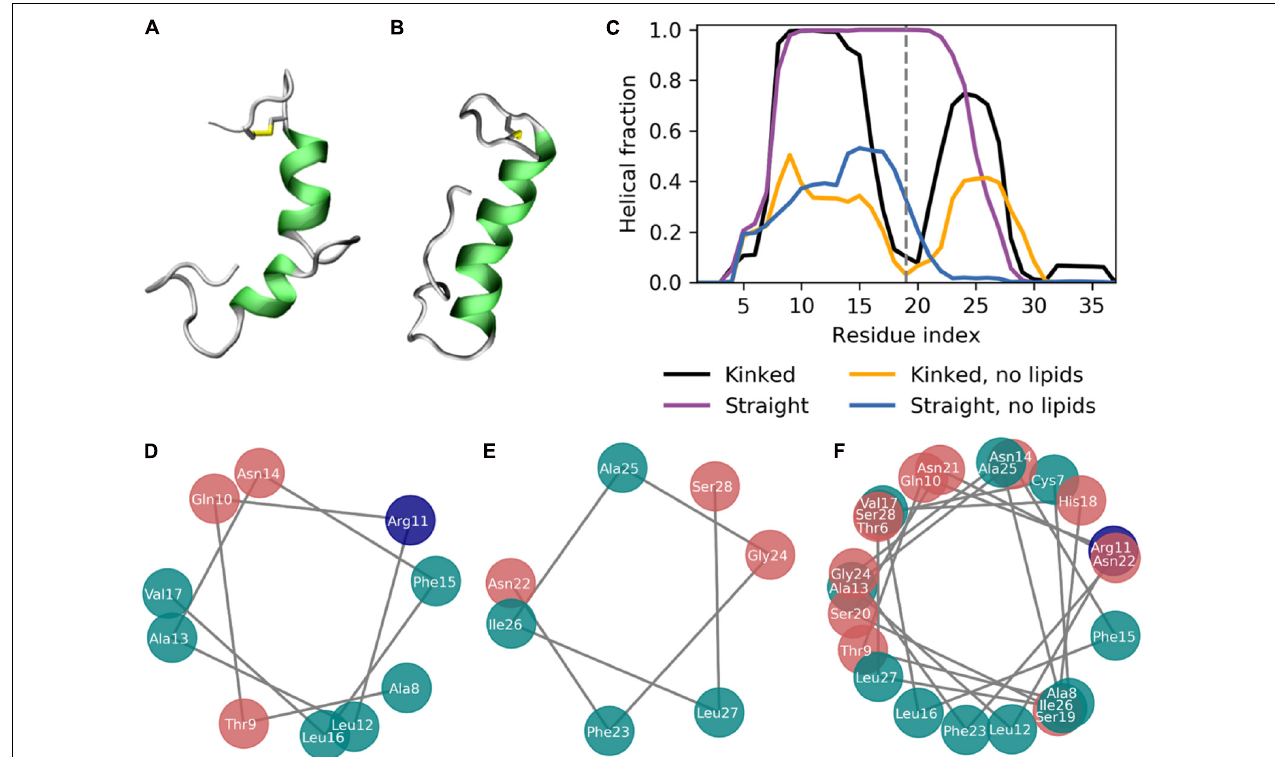
FIGURE 3 | The secondary structure of IAPP in the kinked or straight conformation. (A,B) Simulation structures of a kinked (based on PDB-ID 2L86) and a straight peptide (based on PDB-ID 2KB8) with the helical residues colored green. (C) Fraction of combined simulation time with each residue in a helical conformation for the kinked and straight peptides in the presence, with and without the presence of lipid membranes. (D) Helical wheel of the N-terminal helix of the kinked peptides. (E) Helical wheel of the C-terminal helix of the kinked peptides. (F) Helical wheel of the straight helix of the straight